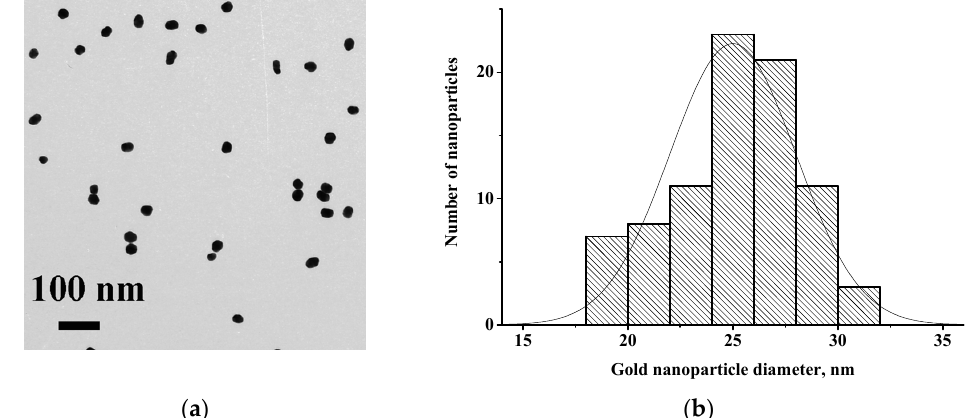
Figure 2. Microphotograph of GNPs obtained by TEM with the indicated scale ( a ); histogram of distribution of GNPs’ diameters ( b ).